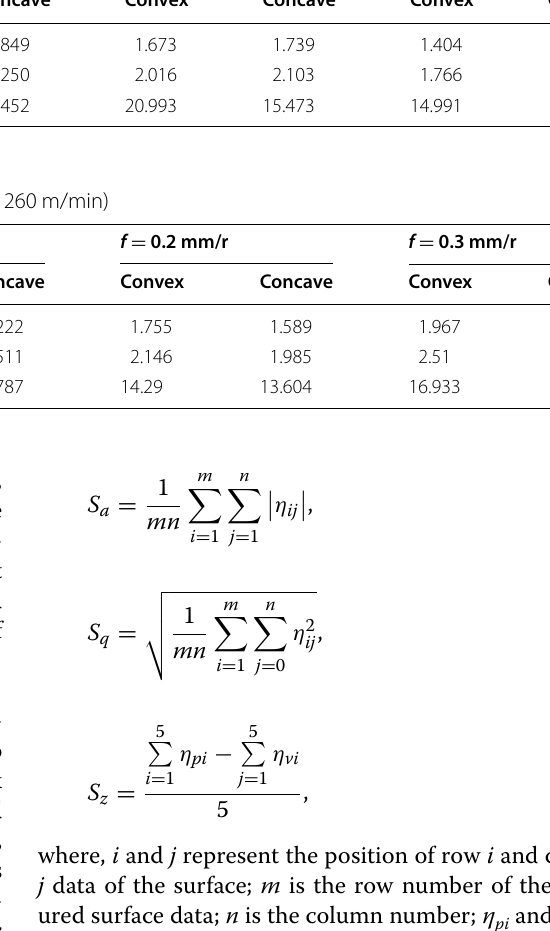
0.1 mm/r) = 170 m/min = Convex Concave Convex Concave Convex Concave